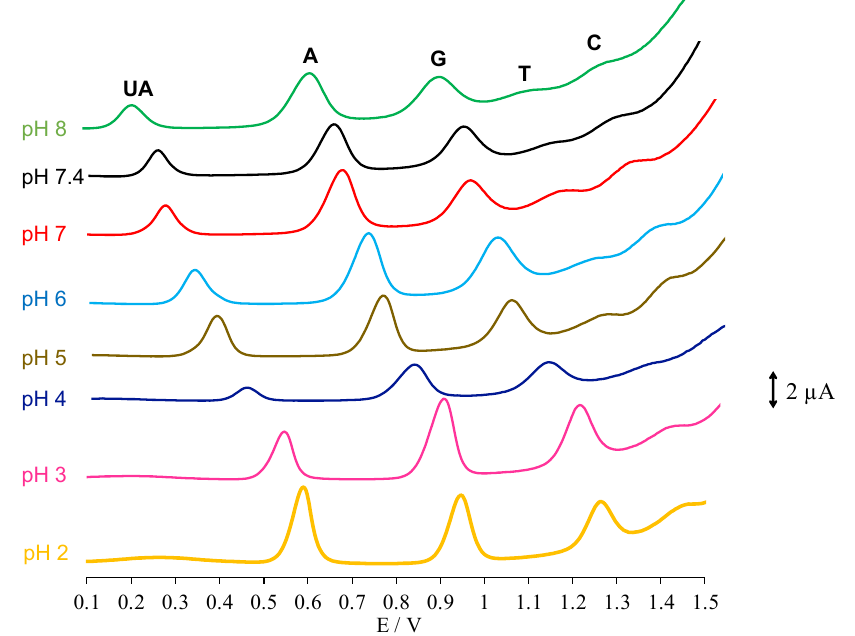
Figure 3. DPV voltammograms using GCE/GO ‐ MWCNT ‐ CHT for pH effect on the simultaneous electrochemical detection of four DNA bases in the presence of UA (pH range: 2.0, 3.0, 4.0, 5.0, 6.0, 7.0, 7.4, and 8.1).